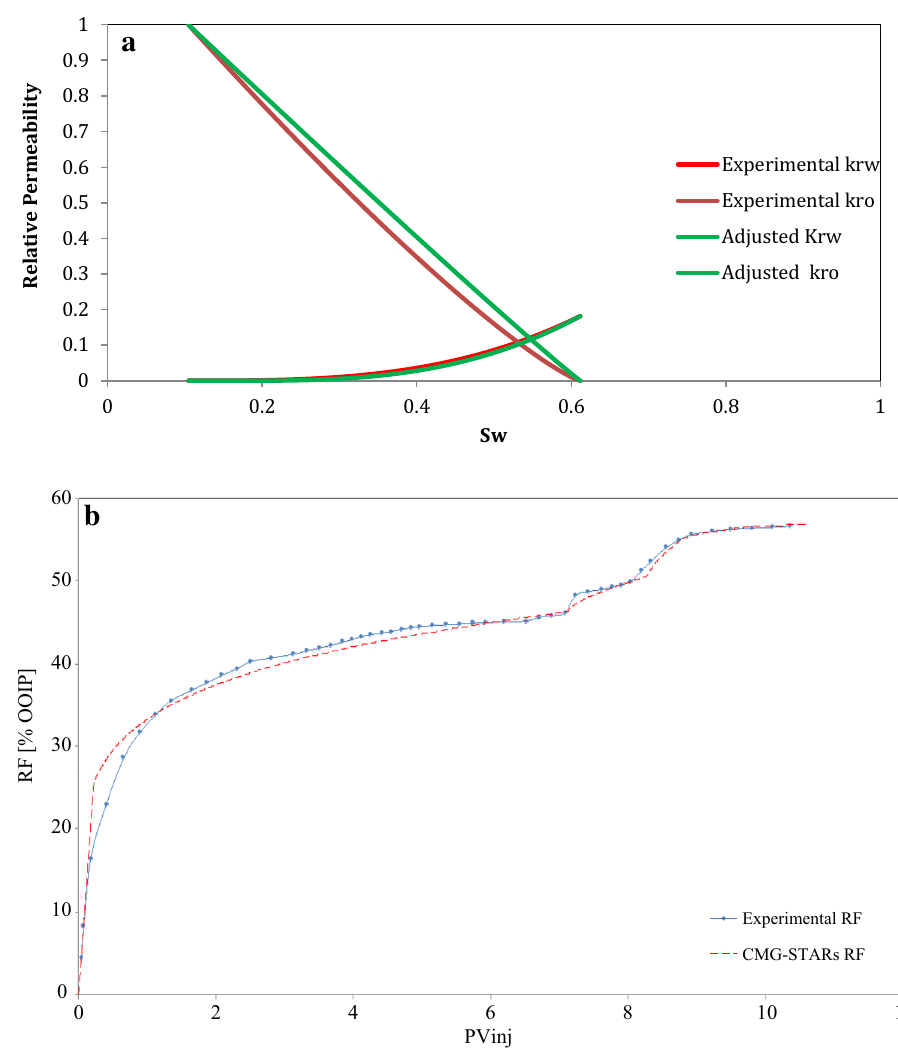
Fig. 6 a Experimental and the best-adjusted relative perme- ability curves. b Effect of tuning both Alkali viscosity and relative permeability curves on cumulative